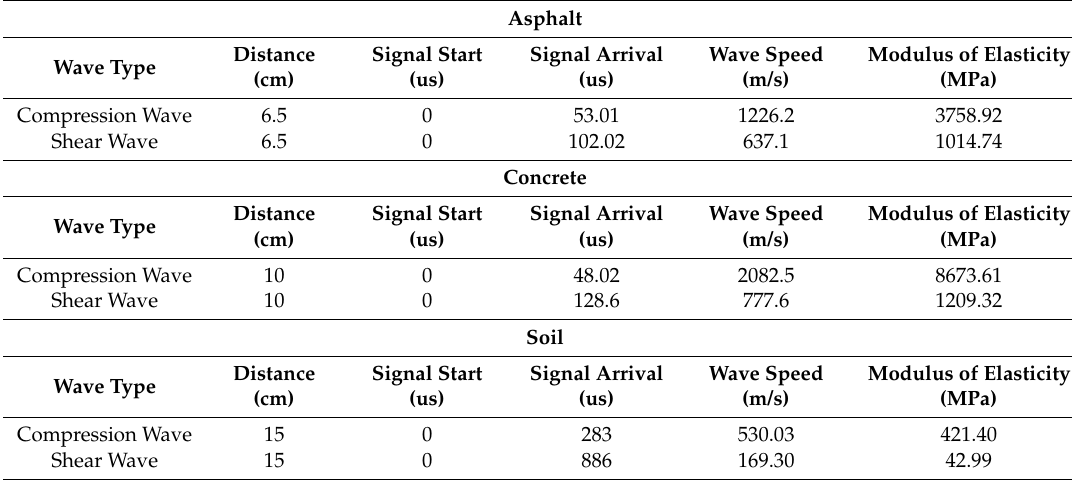
Table 4. Modulus of elasticity measured by the new TDR.